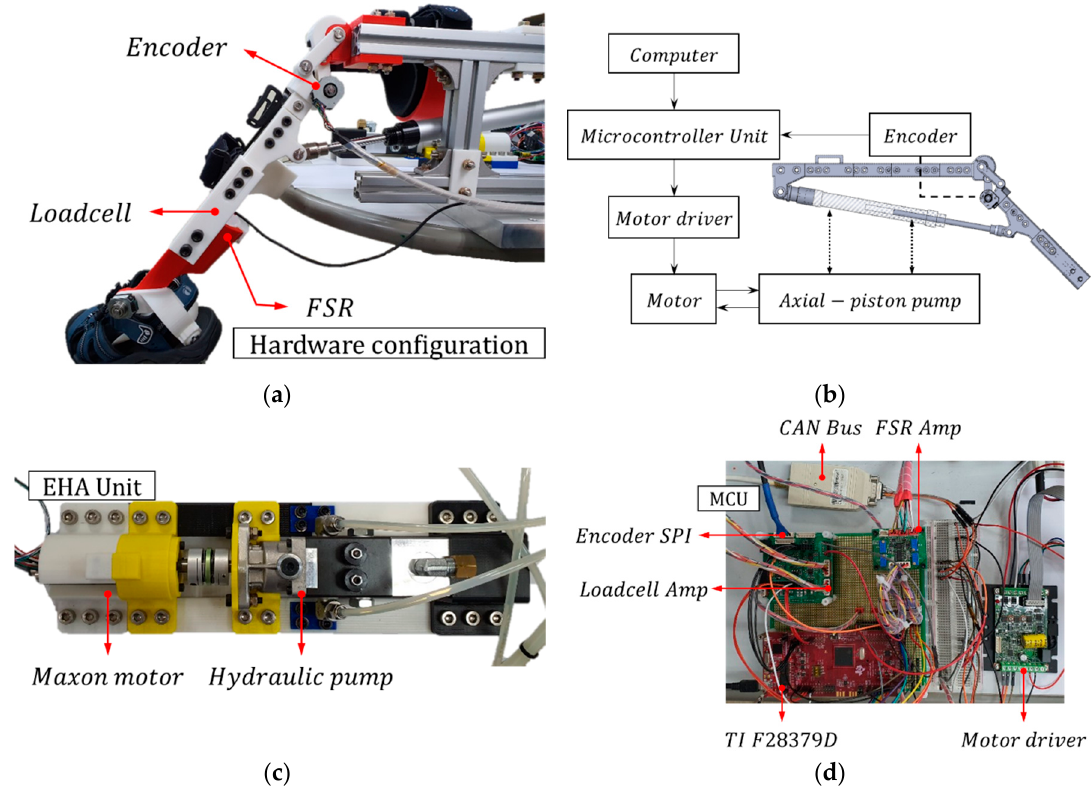
Figure 10. The overall experimental setup attached to a rigid body .